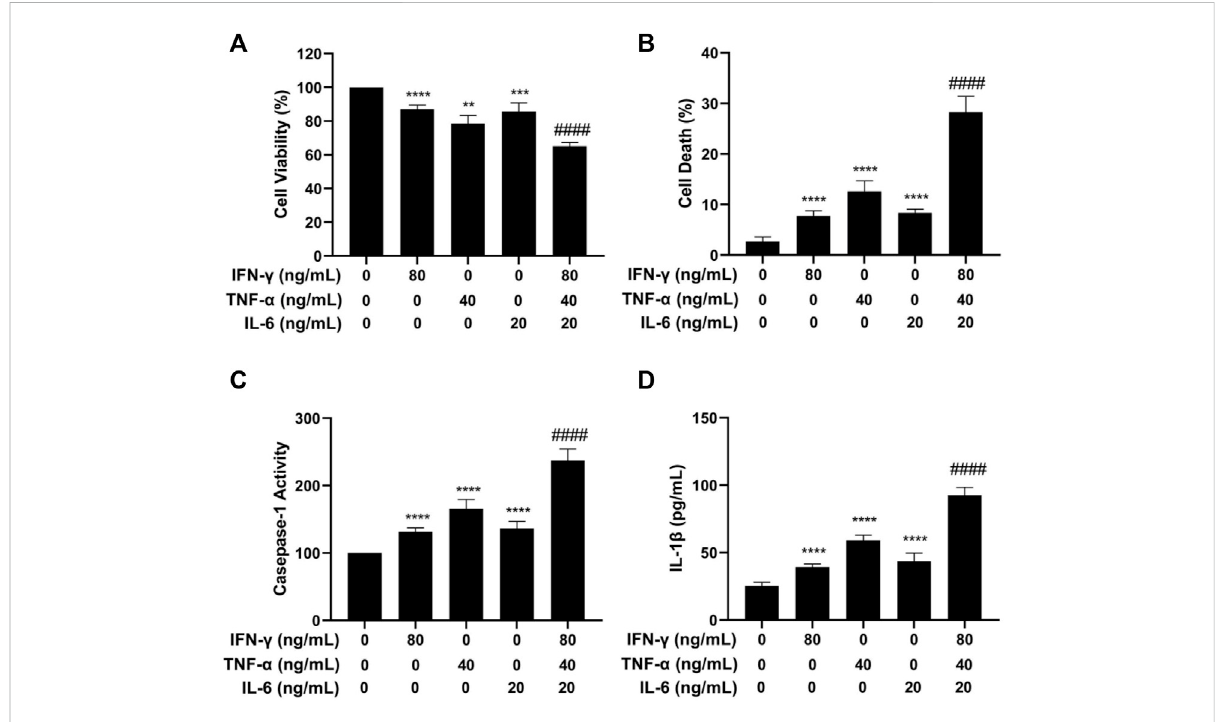
FIGURE 2 Effects of IFN- γ , TNF- α , and IL-6 on cell viability, cell death, caspase-1 activation, and IL-1 β level of HaCaT cells. HaCaT cells were exposed to IFN- γ , TNF- α , and IL-6 alone or in combination for 24 h. (A) The MTT assay was used to determine the cell viability. (B) The Trypan blue exclusion assay was used to determine cell death. (C) Caspase-1 activity was detected by the caspase-1 assay kit. (D) IL-1 β level was measured by ELISA. The data were presented as mean ± SD ( n = 3), ** = p < 0.01, *** = p < 0.001, and **** = p < 0.0001 as compared with the cells treated with IFN- γ , TNF- α , or IL-6